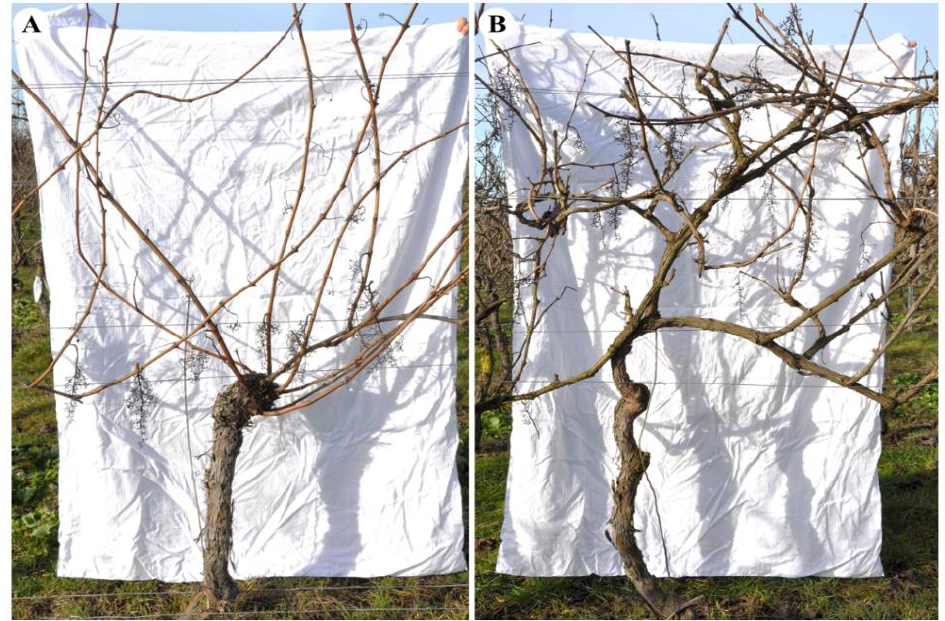
Figure 1. Grapevine cv. ‘Dornfelder’ trained in ( A ) vertical-shoot position (VSP) and ( B ) semi- minimally pruned hedge (SMPH) at dormancy and before winter pruning.